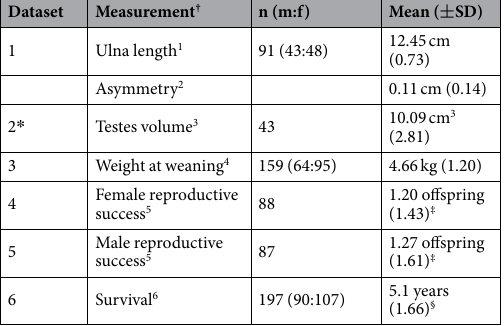
Table 1. Summary of Tasmanian devil fitness measurements collected for the six datasets used in this analysis. * Male subset of dataset 1 . † Superscripts 1–6 correspond to phenotypic traits described in Supplementary Methods. ‡ Reproductive mean includes non-breeders. § Survival mean calculated only from deceased Tasmanian devils during this study period (although all devils were included in the analysis, as reflected by